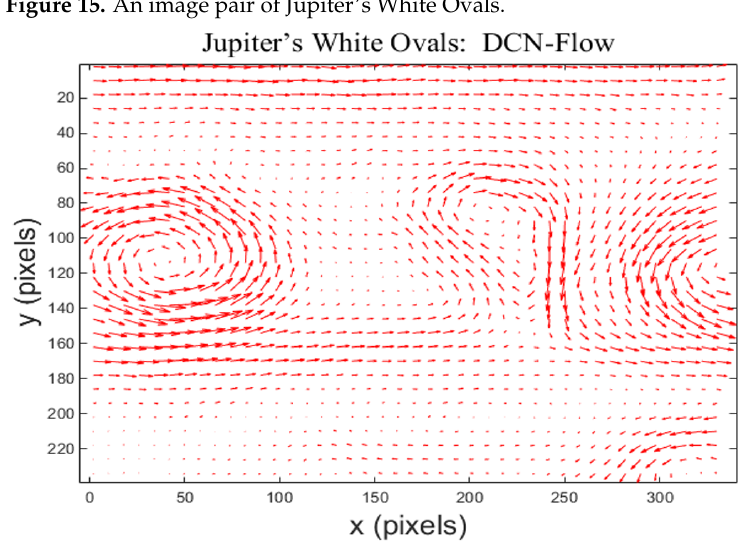
Figure 16. The predicted flow field by our method for Jupiter’s White Ovals.